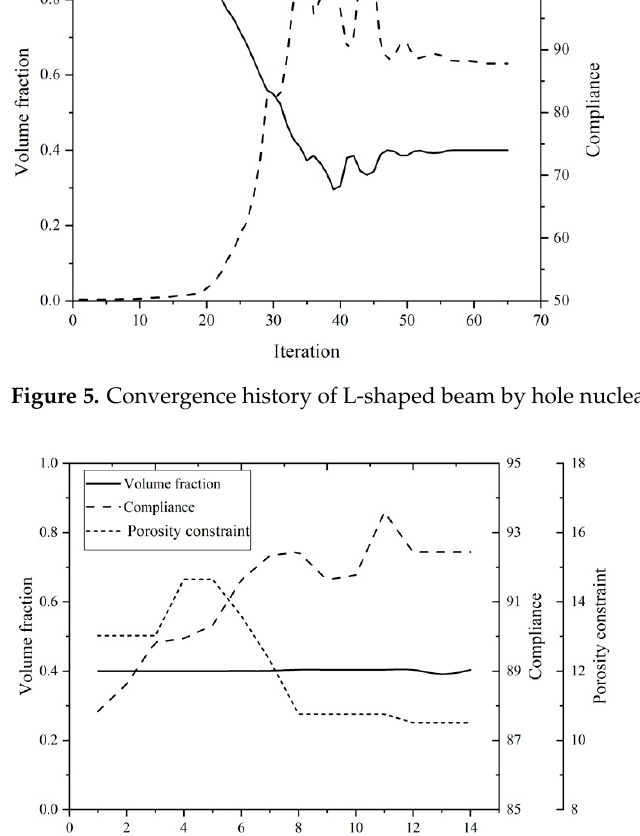
Figure 6. Convergence history of L-shaped beam considering porosity constraint.